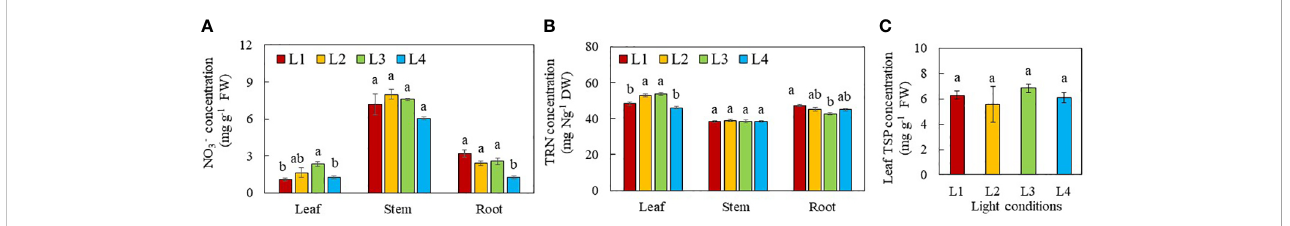
FIGURE 7 NO 3- (A) , TRN (B) and TSP (C) concentrations of purslane grown under different light conditions for 13 days. Values are means ± standard errors. Means with different letters are statistically different ( p <0.05; n =4) as determined by Tukey ’ s multiple comparison test for each plant organ. Refer to Figure 1 for the different conditions of L1, L2, L3 and L4.